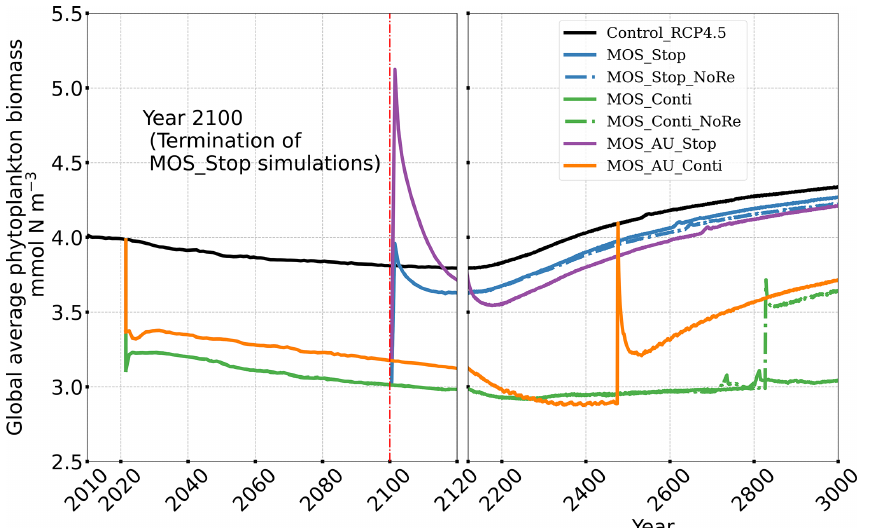
Figure B6. Plot of global averaged phytoplankton biomass.